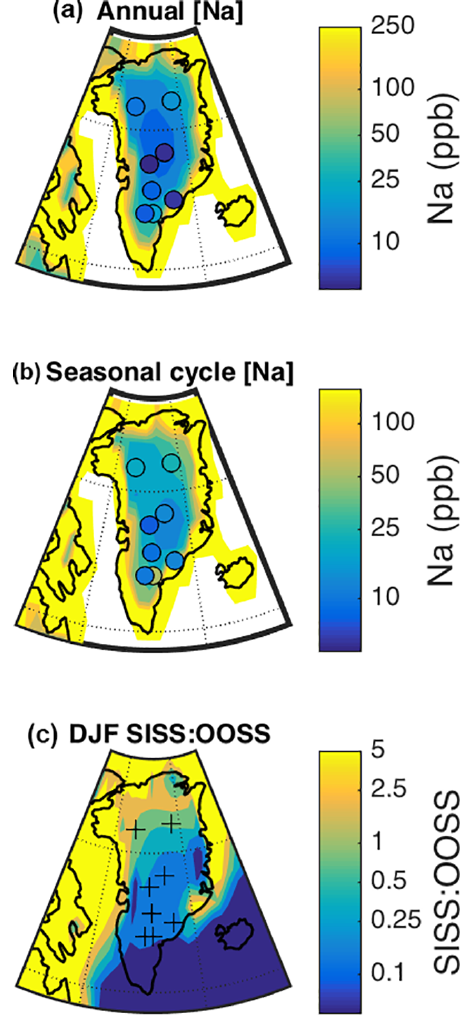
Figure 8. Greenland ice core [Na] simulated by p-TOMCAT (1991– 1999) compared to Greenland ice core data (circles). (a) Annual mean [Na], (b) seasonal cycle in [Na] (maximum monthly [Na] mi- nus minimum monthly [Na], and (c) winter (DJF) SISS:OOSS ra- tio (simulated) with black crosses marking ice core locations. Sim- ulated [Na] values calculated using the modelled accumulation rate (see Table S1 for alternative values at each ice core site if ice core accumulation rate is used). Note the log scales to all colour